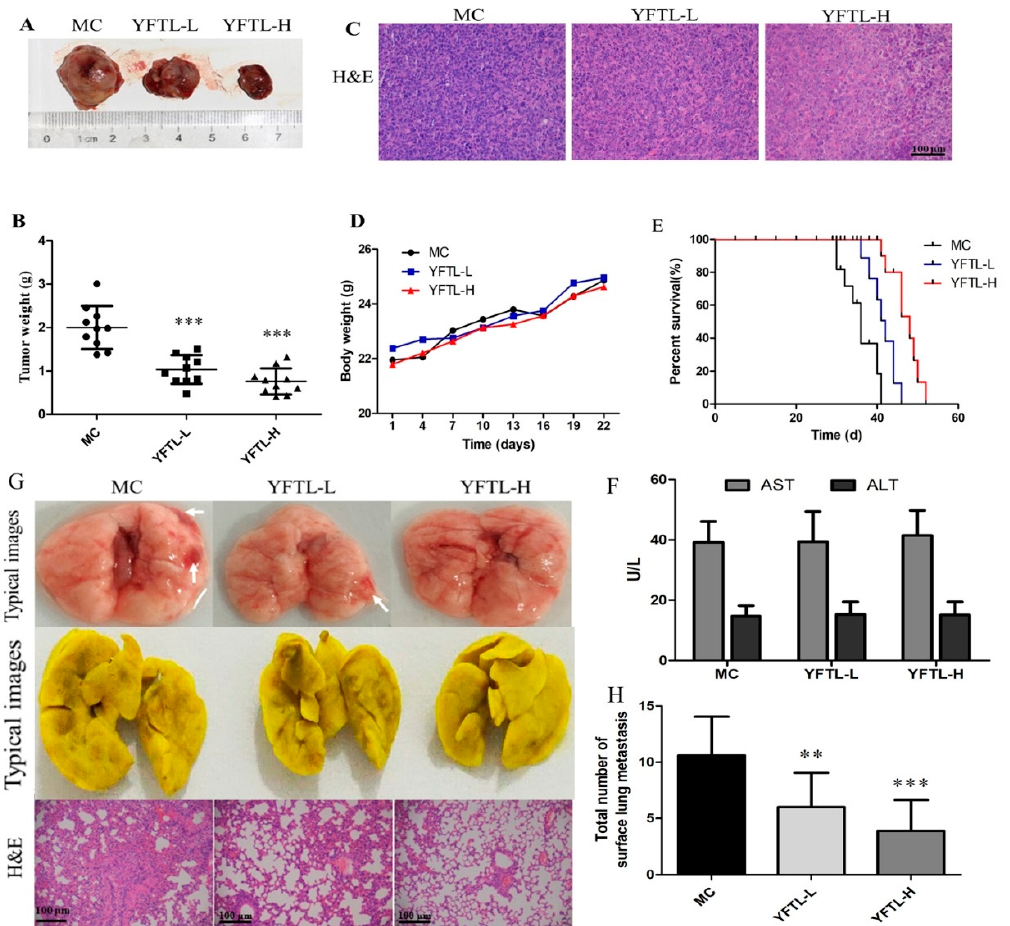
Figure 1. Antitumor and anti-metastasis effects of YFTL in Lewis lung cancer-bearing mice. ( A ) Tumors sampled from experiment groups; ( B ) tumor weight; ( C ) histological analysis of tumor sections stained with HE; ( D ) body weights during the treatment; (E ) survival curves of mice in each group; ( F ) concentration of AST (U/L) and ALT (U/L) in serum of the mice shown as the mean ± SD. ( G ) Representative photographs of the whole lungs from mice in each group and HE staining of the lung tissue sections; and ( H ) the total number of nodules on the whole lung tissues. MC: model control group, treated with 0.5% sodium carboxymethyl cellulose solution by gavage; YFTL-L: treated with 200 mg/kg/day YFTL by gavage; YFTL-H: treated with 400 mg/kg/day YFTL by gavage. Data are expressed as the mean ± SD. ** p < 0.01 and *** p < 0.001 vs. the MC group.